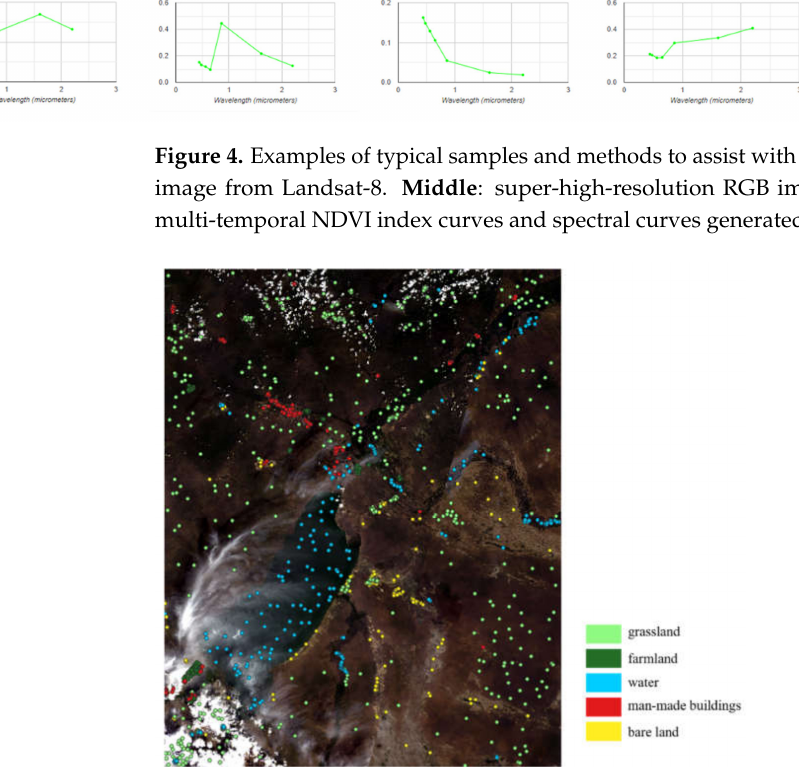
Figure 5. Landsat-8 image (4, 3 and 2 bands) and samples used in our